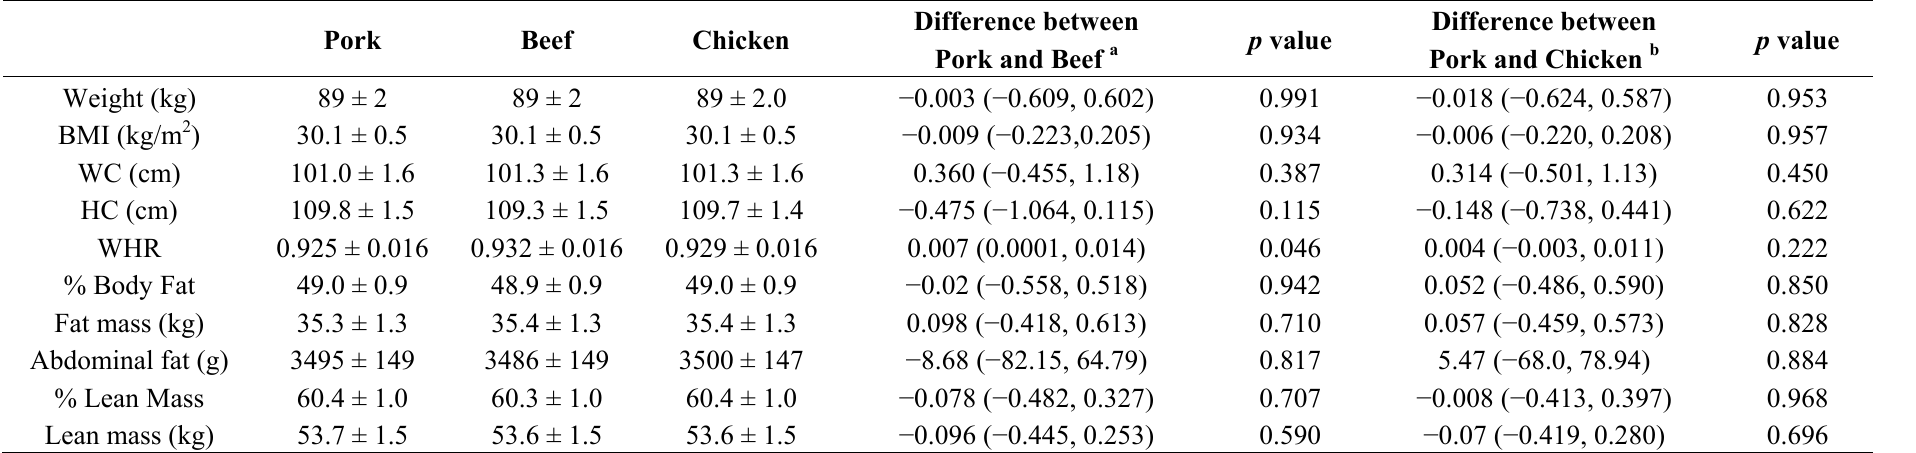
Table 3. Mean values for anthropometric measurements and body composition * at the end of each diet phase (Pork, Beef, Chicken), n = 49 and difference between meats (95% confidence